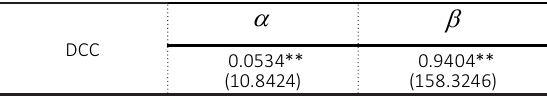
Table 3. DCC conditional correlation estimates: three markets a